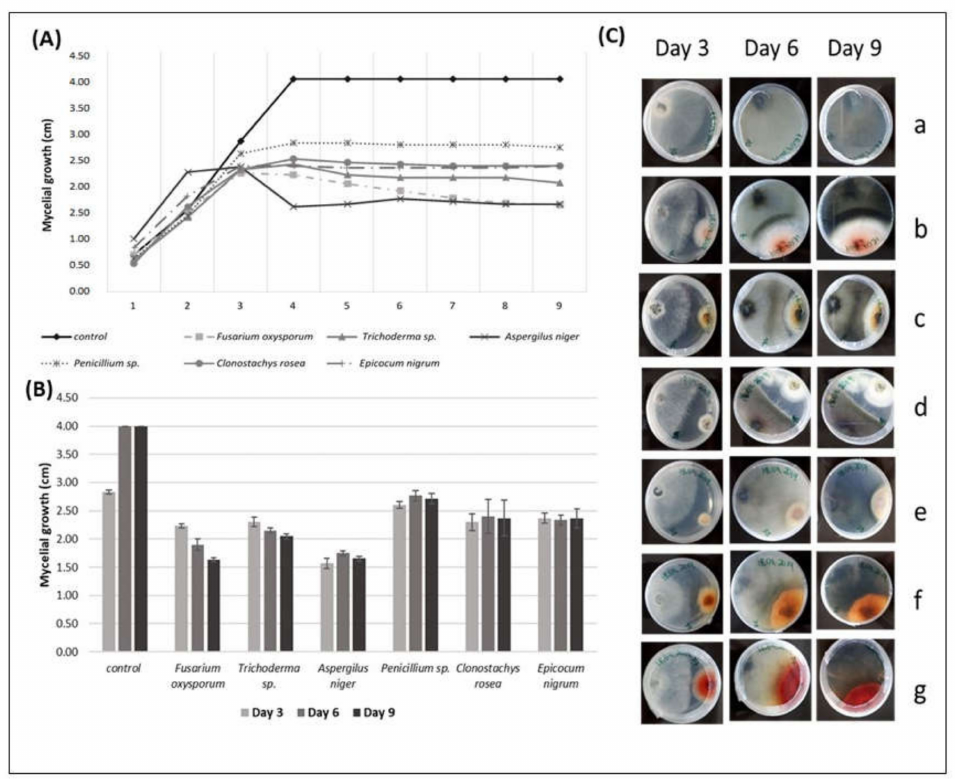
Figure 2. ( A ) The radial mycelial growth (cm) of Diplodia pseudoseriata over time (days), registered in direct inhibition tests with some endophytic fungi; ( B ) radial growth values of Diplodia pseudoseriata (cm) (r D. pseudoseriata ± SE) in the presence of di ff erent endophytic fungi on the 3rd, 6th, and 9th day of direct antagonism test; ( C ) interactions of Diplodia pseudoseriata , over the days, with grapevine endophytic fungi. Diplodia pseudoseriata on the left side and the endophytic on the right side of the Petri dish. ( a ) Diplodia pseudoseriata (control), ( b ) Diplodia pseudoseriata vs. Fusarium oxysporum , ( c ) Diplodia pseudoseriata vs. Trichoderma sp., ( d ) Diplodia pseudoseriata vs. Aspergillus niger , ( e ) Diplodia pseudoseriata vs. Penicillium sp., ( f ) Diplodia pseudoseriata vs. Clonostachys rosea , ( g ) Diplodia pseudoseriata vs. Epicocum nigrum. Pictures from the reverse side of the